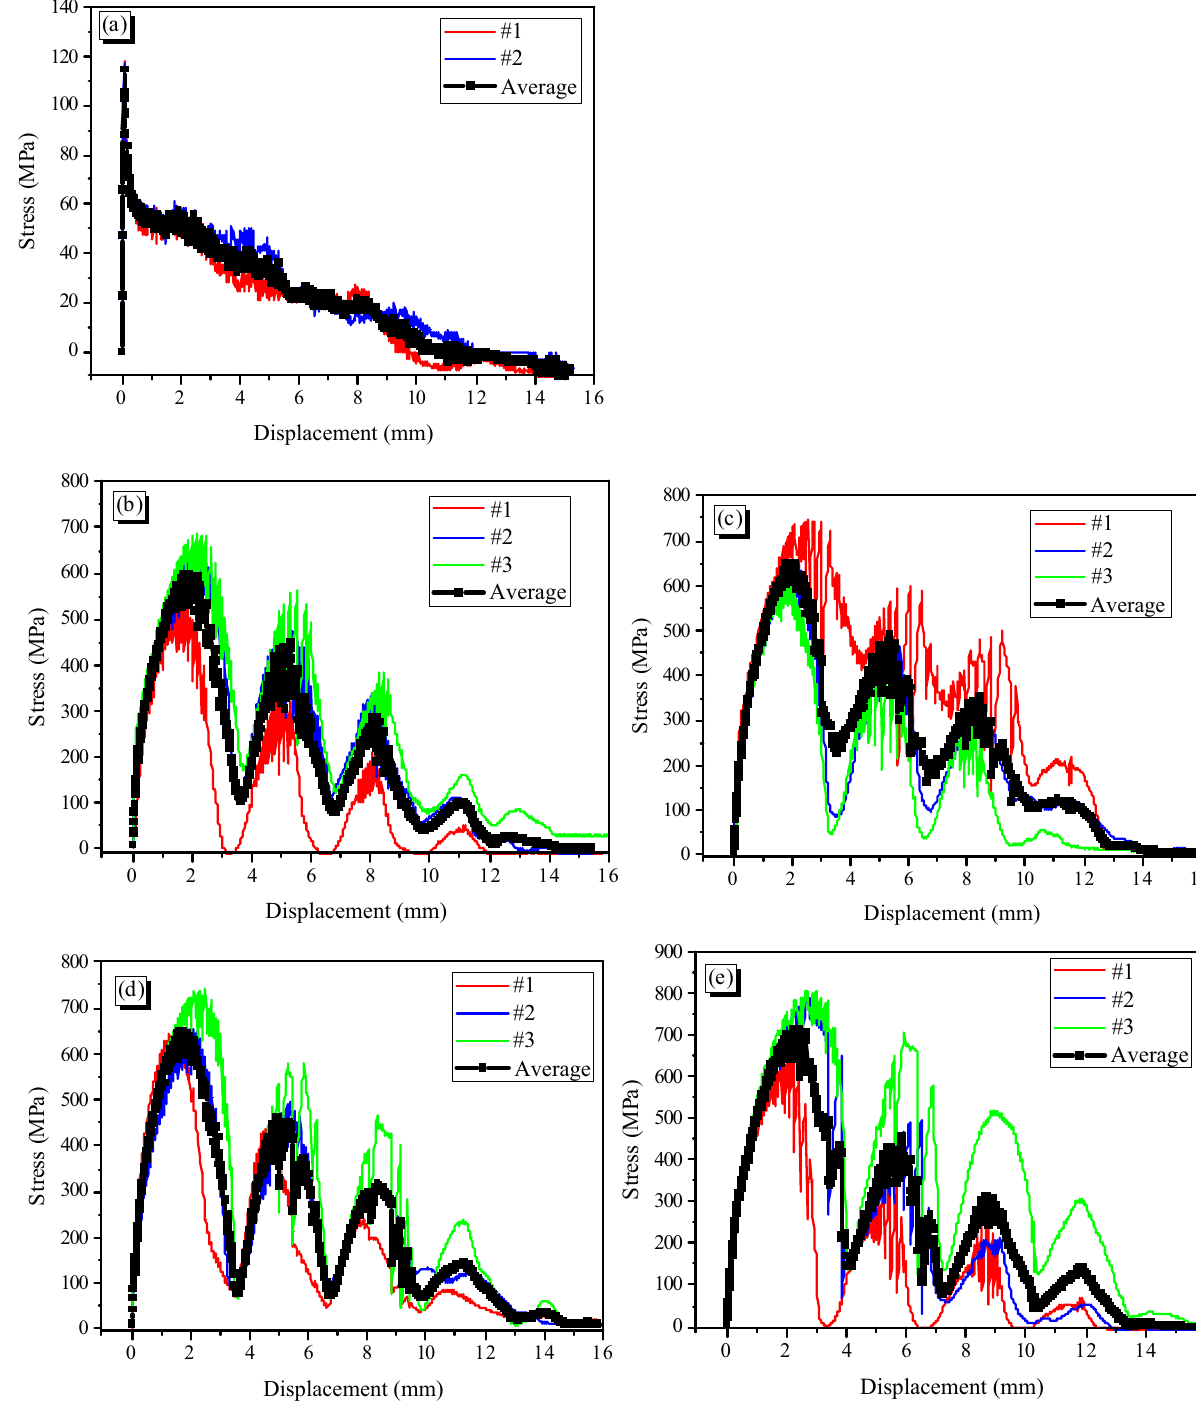
Figure 5: Pullout stress – displacement curves of the fi bers in nonheating case: ( a ) ST, ( b ) CR1, ( c ) CR2, ( d ) CR3, and ( e )